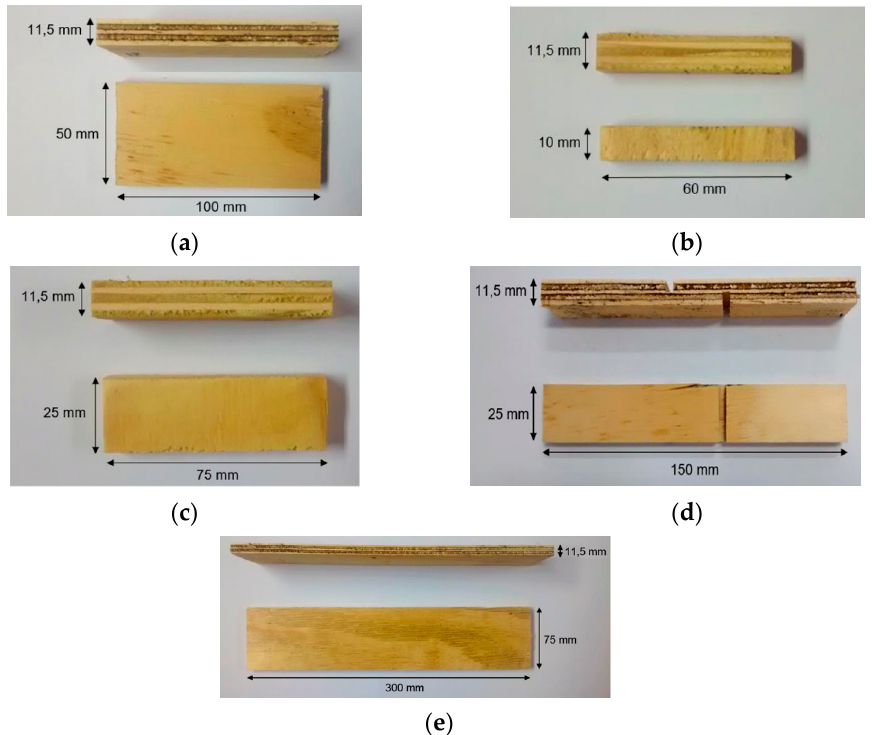
Figure 3. Samples’ dimensions used to characterize the panels: ( a ) moisture content, ( b ) thickness swelling, ( c ) water absorption, ( d ) glue line shear and parallel and ( e ) perpendicular static